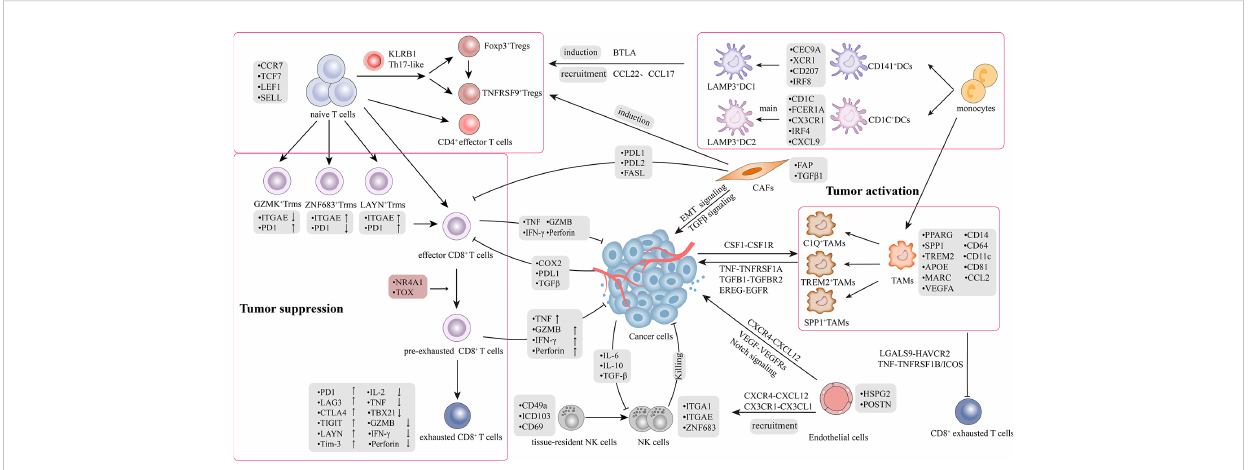
FIGURE 1 Tumor microenvironment and crosstalk in lung cancer. The picture recapitulated in-depth interaction mechanisms and signal transduction pathways between heterogeneous cell subpopulations in TME. TME comprises highly heterogeneous cancer cells and stromal cells, including T cells, B cells, natural killer cells (NKs), tumor-associated macrophages (TAMs), dendritic cells (DCs), CAFs and endothelial cells (ECs). There was a bidirectional interaction between the tumor and stromal cells within the TME. The interaction is classi fi ed into two aspects: 1) Bidirectional regulation between tumor and stromal cells; 2) Crosstalk among stromal